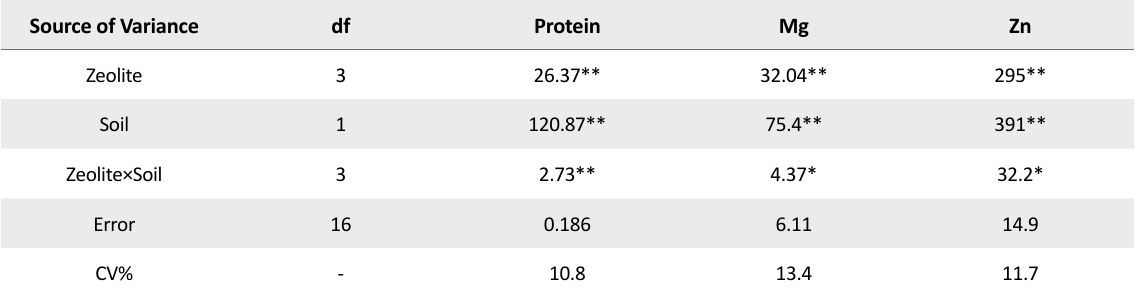
Table 3. Results of analysis of variance for protein, Mg and Zn of wheat grain Source of Variance